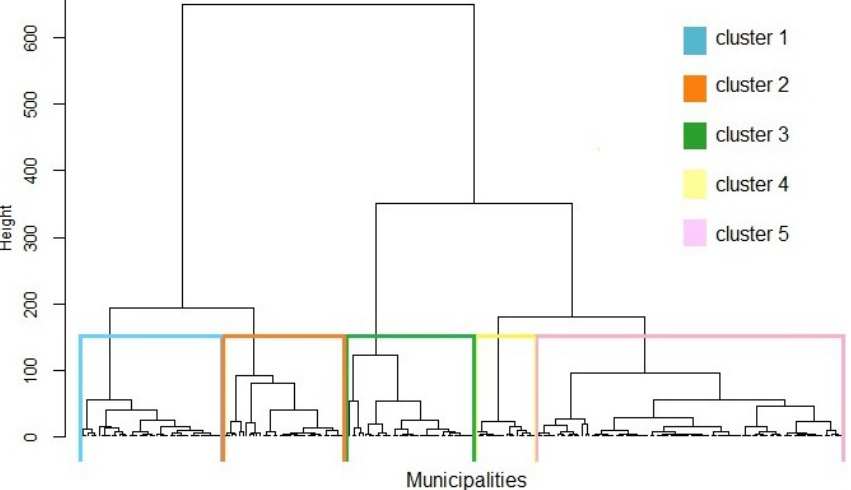
Figure 1. Dendrogram of the n = 223 municipalities based on the 5 socio-epidemiologic variables (that is using D 0